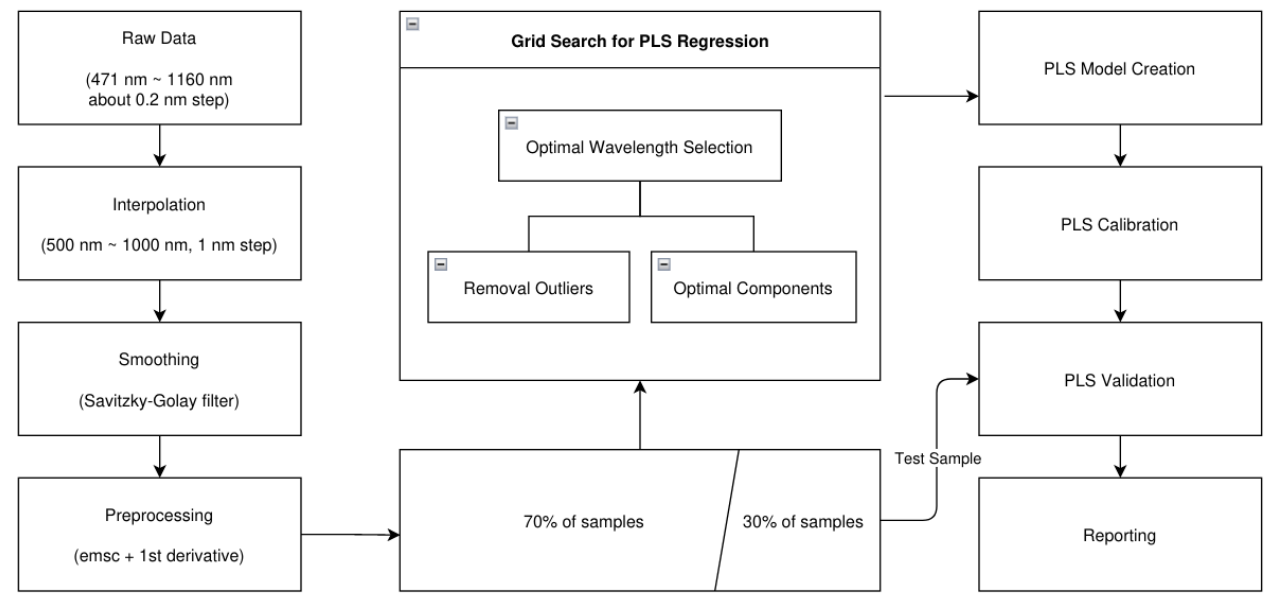
Figure 3. Algorithm of PLS regression comprising signal preprocessing (interpolation, smoothing, and preprocessing), sample splitting, grid search for optimal parameters, PLS calibration, validation, and reporting.